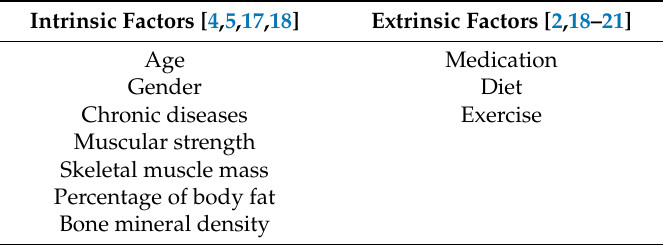
Figure 1. Osteosarcopenic obesity consequences. ↑ : increased; ↓ : decreased Table 1. Factors associated with development of osteosarcopenic obesity syndrome.